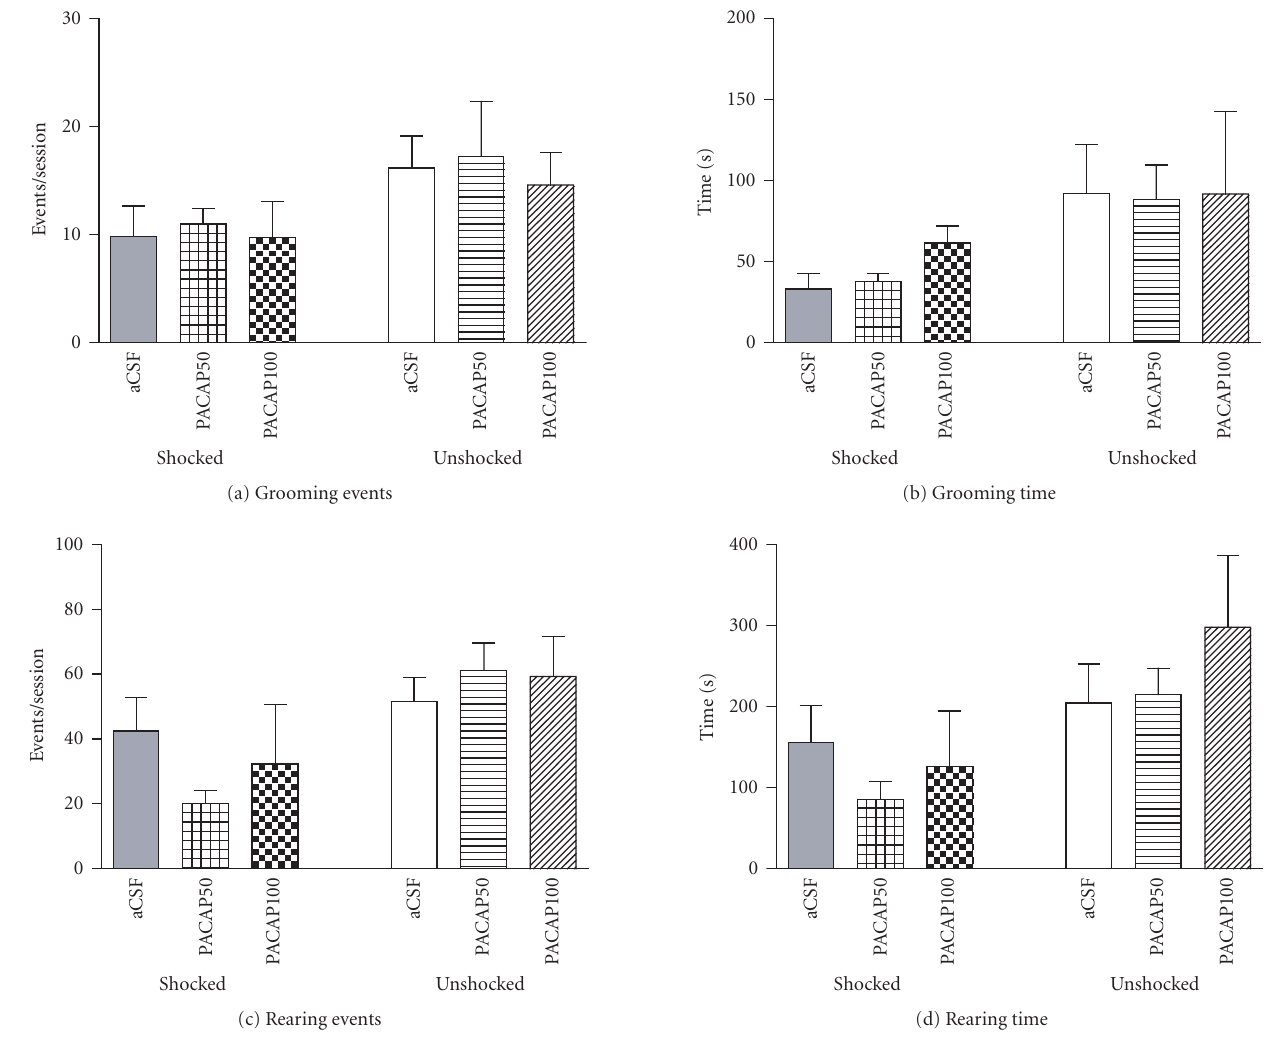
Figure 6: Grooming and rearing behaviors of shocked and unshocked rats in the shock-probe fear chamber. Intra-CeA PACAP microinjec- tion had no statistically significant e ff ects on grooming events (a) and time (b) or rearing events (c) and time (d) in shocked or unshocked groups of rats, relative to their respective aCSF-injected